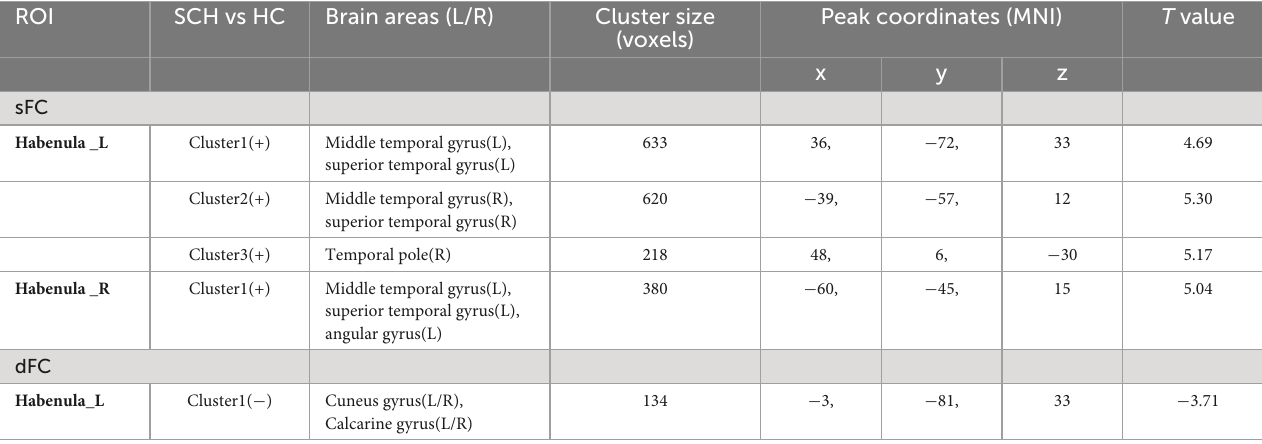
TABLE 2 Whole-brain seed-based static functional connectivity and dynamic functional connectivity analysis results.